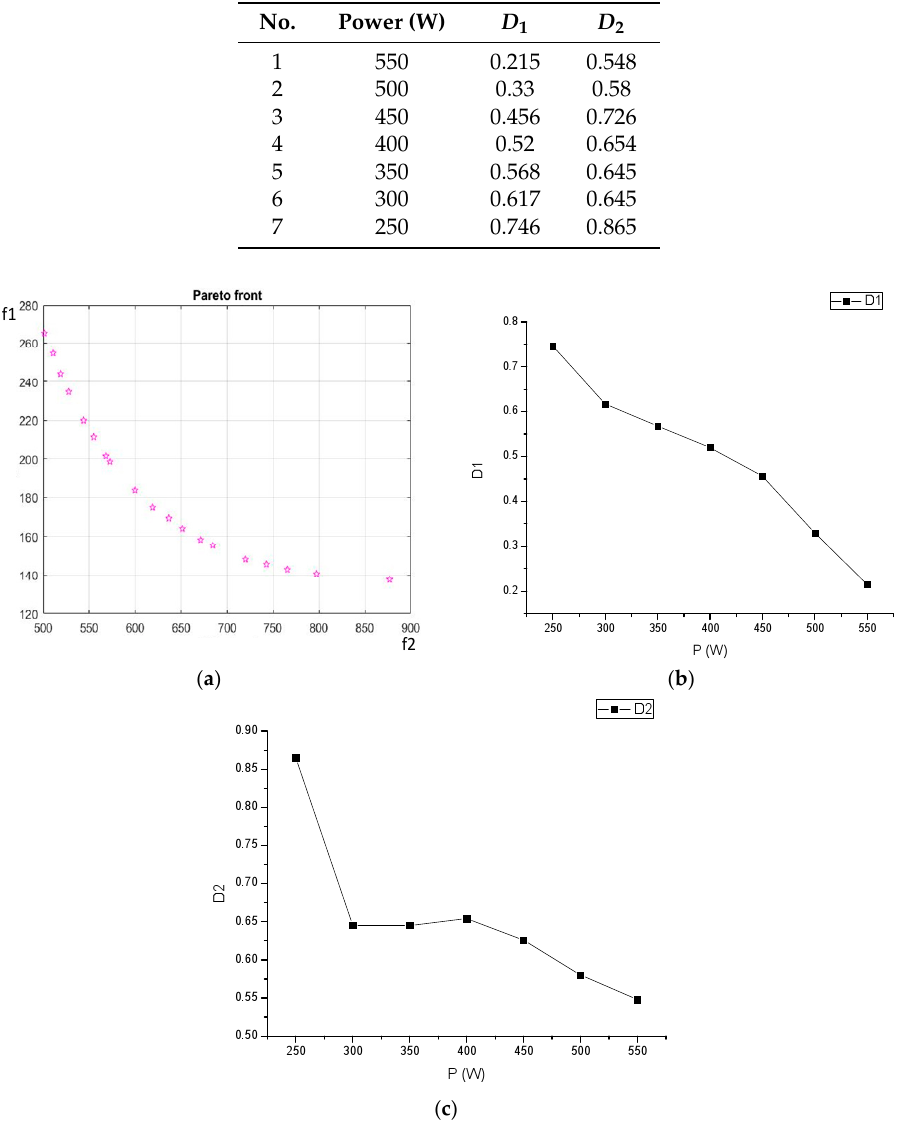
Figure 5. ( a ) Pareto front on rated condition ( b ) Relation curve of D 1 and power ( c ) Relation curve of D 2 and power.